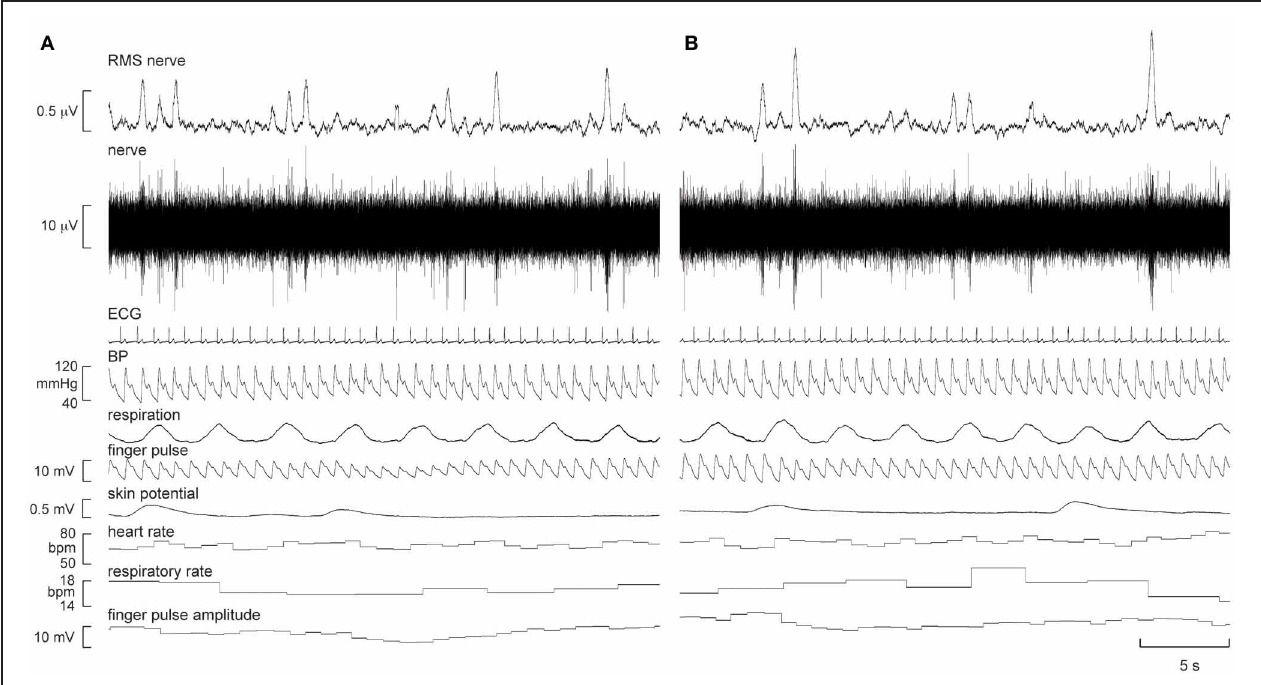
FIGURE 1 | Experimental records of muscle sympathetic nerve activity (MSNA), ECG, blood pressure, respiration, sweat release (skin potential), and skin blood flow (finger pulse) in one subject at rest